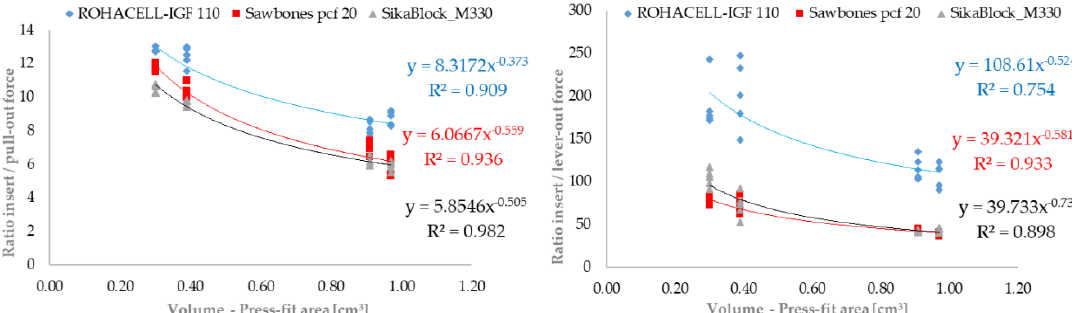
Figure 5. Representation of press-in ratio and to the forces determined experimentally for pull-out test and lever-out test in comparison to the press-fit volume of the tested acetabular cup variant (n = 5).